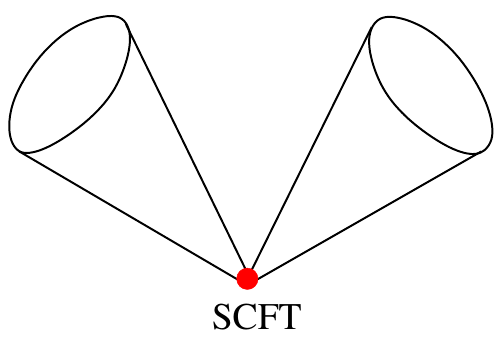
Figure 1 . A cartoon illustrating di(cid:11)erent branches of vacua in a SCFT. Aside from the original SCFT, one can also speak of a theory on each given